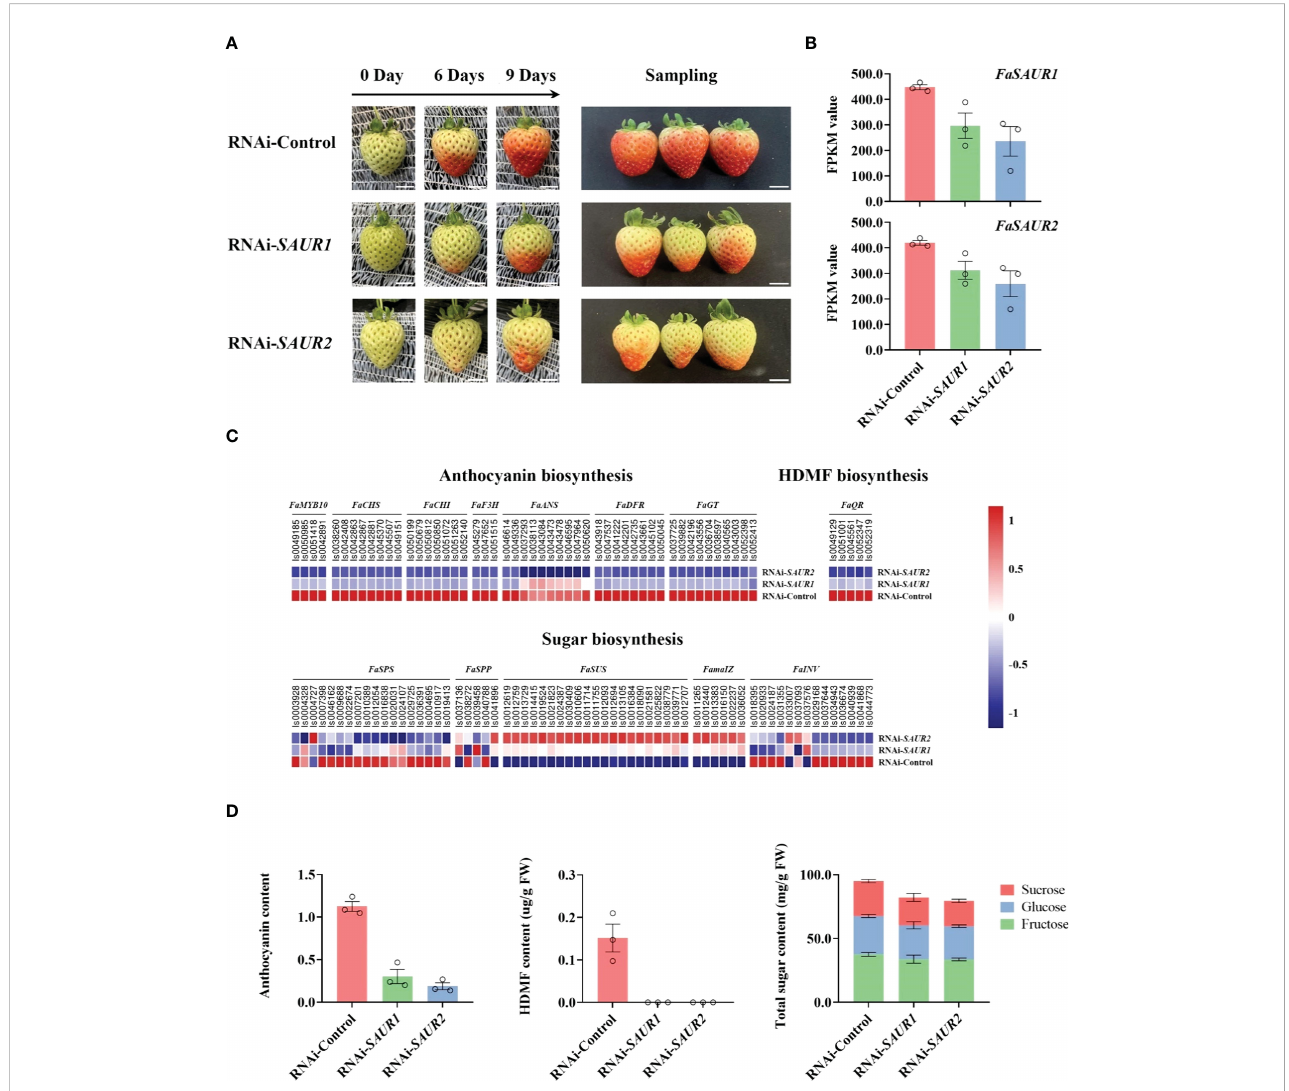
FIGURE 6 Transiently RNAi assays of FaSAUR1 and FaSAUR2 in strawberry fruit. (A) Phenotypes of fruit after transiently suppressing FaSAUR1 or FaSAUR2 using RNAi. The left picture shows the control (injecting empty vector, named as RNAi-Control) and RNAi (named RNAi- FaSAUR1 and RNAi- FaSARU2 ) fruit at 0, 6, and 9 days, The right picture shows the fruit at sampling stage (9 days). Scale bar = 1 cm. (B) Expression levels of FaSAUR1 or FaSAUR2 in the control and RNAi fruit based on the FPKM of Isoform0051199 and 0051401. (C) Heatmap of expression pro fi les of genes involved in anthocyanin, HDMF, and sugar biosynthesis in the samples of transient assays, based on FPKM values. (D) Levels of anthocyanin, HDMF, and total sugars in the RNAi-Control and RNAi- FaSAUR1 and RNAi- FaSAUR2 fruit. The data represent the mean ± SD of three biological